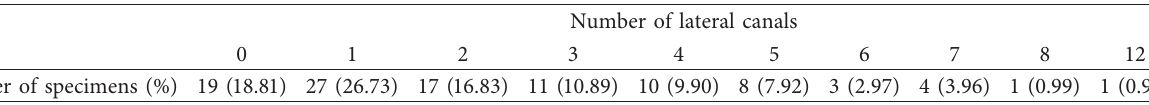
Table 4: Number of specimens ( n � 101) with lateral canals